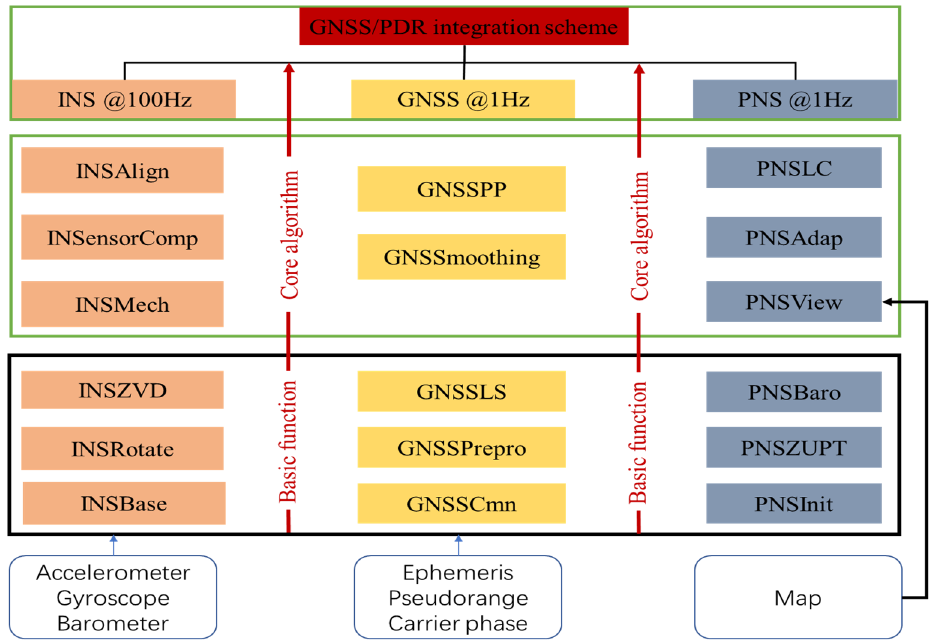
Figure 2. The overall architecture of the scheme.